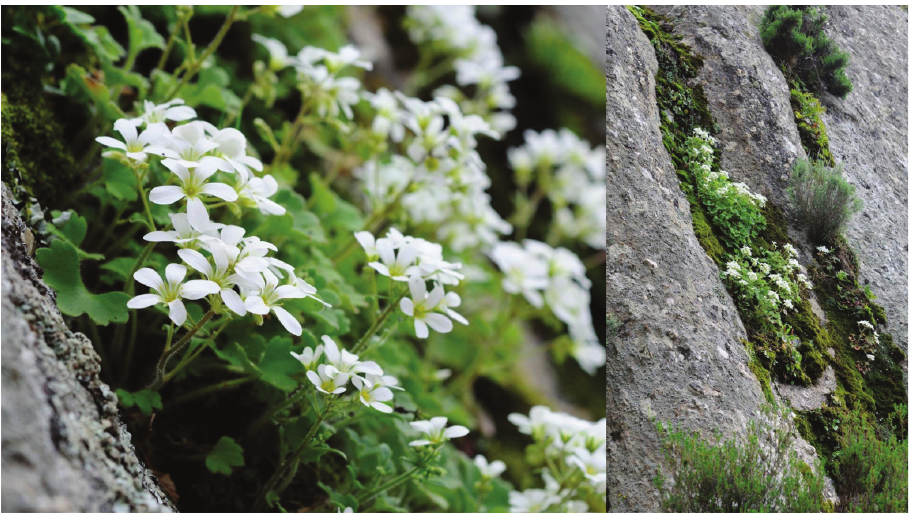
Figure 3. Saxifraga montis-christi in “Collo dei Lecci” Valley, Montecristo Island (Tuscan Archipelago). Photograph by L.